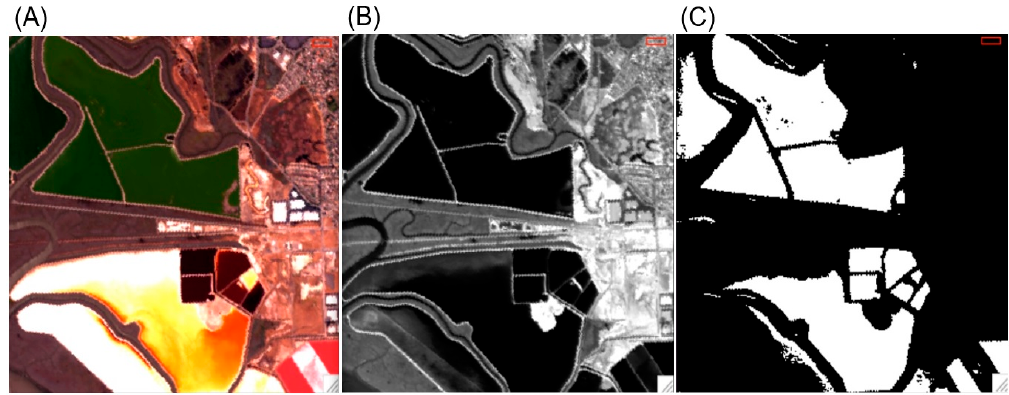
Figure 2. ( A ) A true color RGB image processed from an AVIRIS data set measured over salt evaporation ponds in the southern portion of the San Francisco Bay at UTC 20:21:00 on 26 August 2009 when the green and red algae were present; ( B ) The 2.25 ‐μ m channel image over the same area; ( C ) The floating vegetation mask.